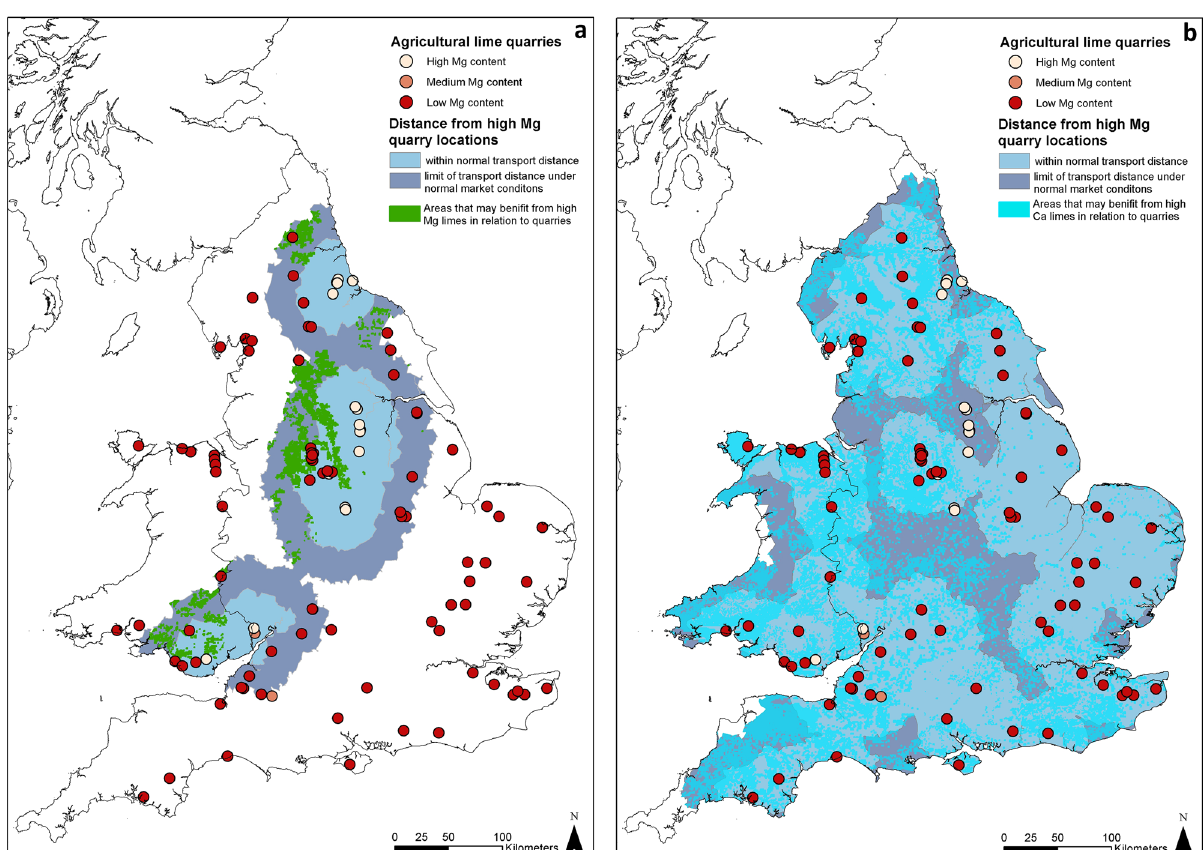
Figure 8. The results of the supply/demand analysis, ( a ) estimated normal and maximum transport distances from quarries supplying high Mg limes and the areas within them that may benefit from high Mg limes. ( b ) Estimated normal and maximum transport distances from quarries supplying low Mg (and therefore high Ca limes) and the areas within them that may benefit from high Ca limes. Created using ArcMap 10.7.1, ESRI,